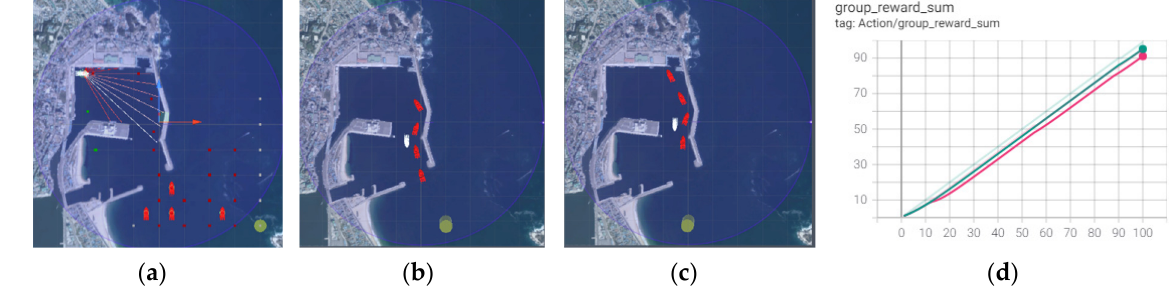
Figure 10. ( a ) Initial experiment environment set to avoid collision among inward ships, ( b ) ILFAS RL, and ( c ) random RL selecting the right path and successfully departing from the harbor. ( d ) The success rate exceeds 95% of ILFAS (Green) and 90% of Random RL (Red) in each 100 episodes.